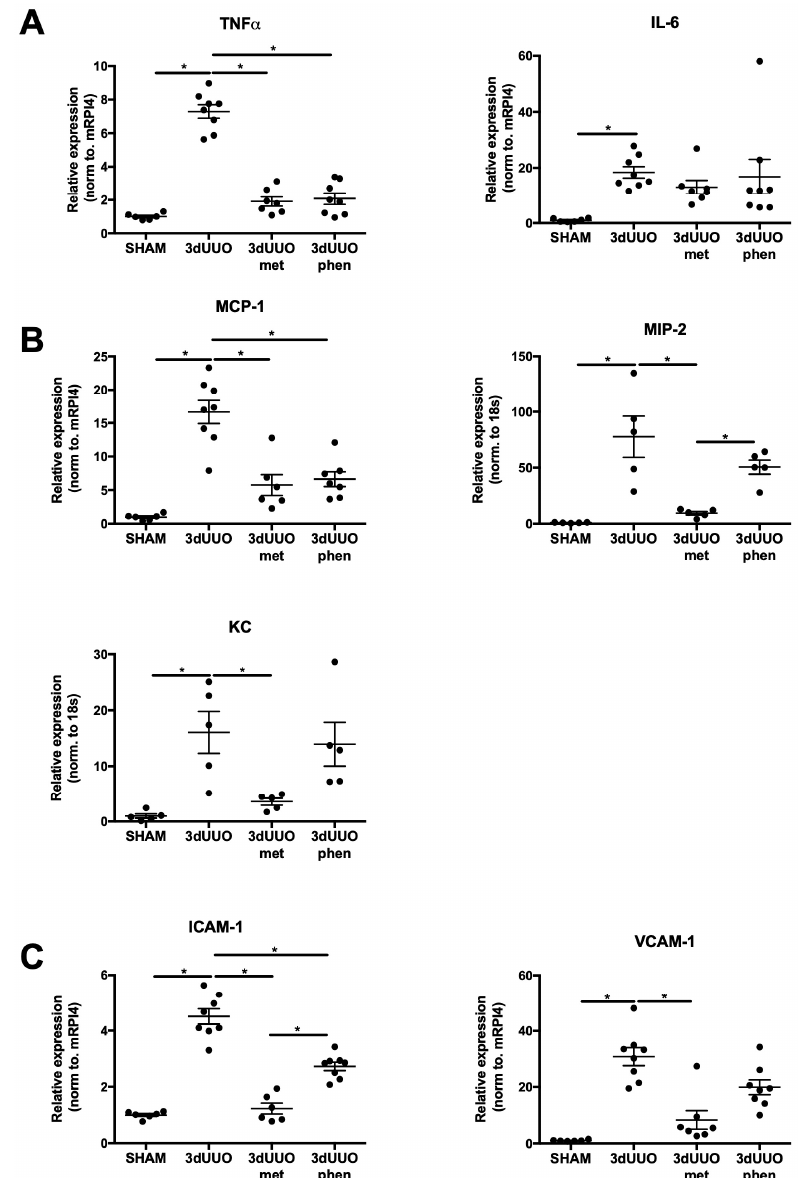
Figure 5. Biguanides differentially impact cytokine expression in response to UUO. ( A ) Relative mRNA expression of the inflammatory markers tumor necrosis factor α (TNF α ) and interleukin 6 (IL-6) in response to 3dUUO and biguanide treatment normalized to ribosomal protein L4 (RPl4). ( B ) Relative mRNA expression of macrophage inflammatory protein 2 (MIP-2) and keratinocyte-derived chemokine (KC) in response to UUO and biguanide treatment normalized to 18s. ( C ) Relative mRNA expression of intercellular adhesion molecule 1 (ICAM-1) and vascular cell adhesion 1 (VCAM-1) mRNA in response to UUO and biguanide treatment normalized to RPl4. n = 6–8 for each group. Each bar represents the mean ± SEM. * p <